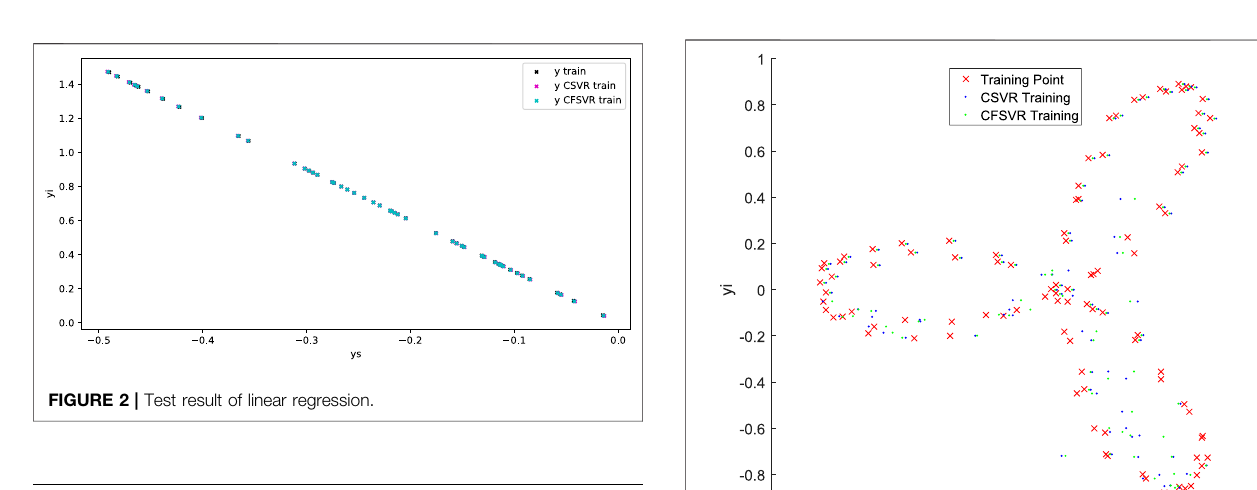
TABLE 1 | Performance of CFSVR and CSVR on linear